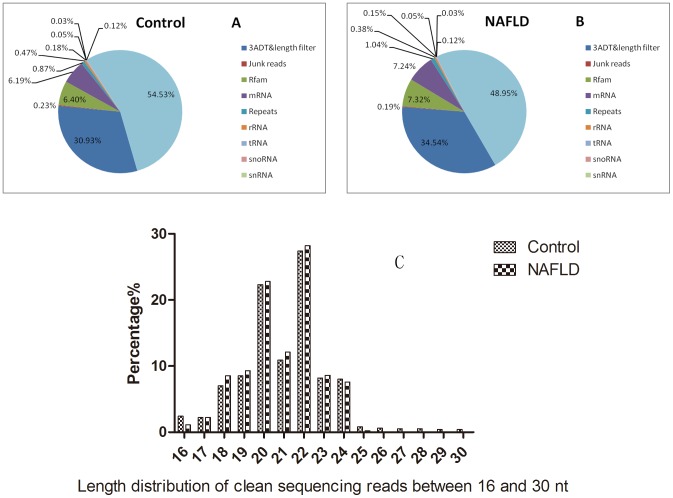
Sequenced reads and distribution of reads.The Illumina GA IIx sequencing of the small RNA library from the serum of healthy controls and NAFLD patients produced 906,910 and 944,362 raw-reads, respectively. After extensive preprocessing and quality control, these raw reads were reduced to 494,523 and 462,263 clean reads, indicating 54.53% and 48.95% of sequenced reads (Figs. 2A, 2B). The entire distribution of reads from 16 to 30 nt is presented in Fig. 2C.